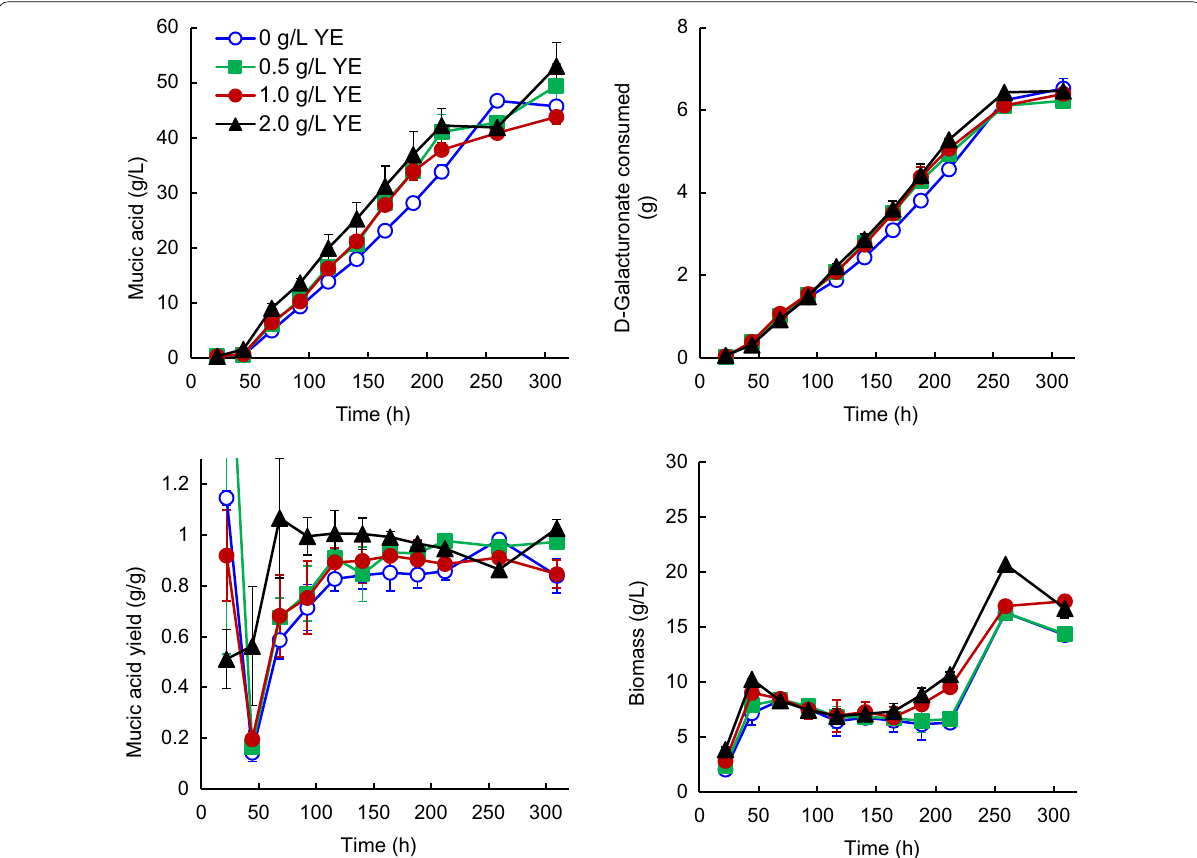
Fig. 3 Concentrations of mucic acid and biomass produced and total amount of galacturonic acid consumed, along with the yield of mucic acid on D-galacturonic acid for cultures of D-221704 grown in fed-batch culture at pH 4.0 with 0 (open circle), 0.5 (solid square), 1.0 (solid circle) or 2.0 (solid triangle) g L − 1 yeast extract. Error bars represent standard error of the mean for 2 ±